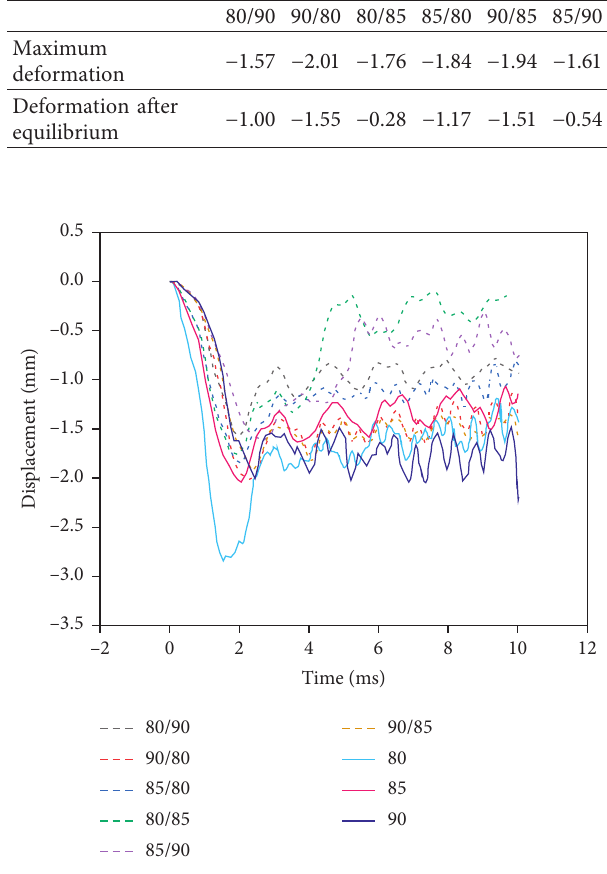
Figure 11: Displacement of single-layer aluminum foam bottom plate. Table 5: Upper aluminum foam energy.